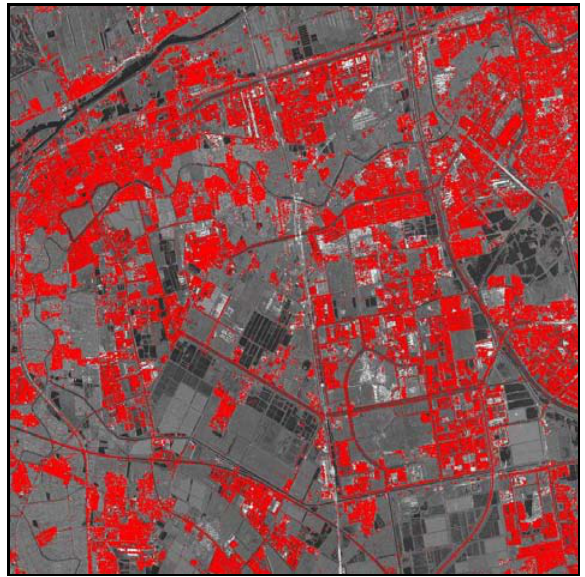
Figure 4. The distribution of the TCPs identified from 23 USB interferometric pairs for the study